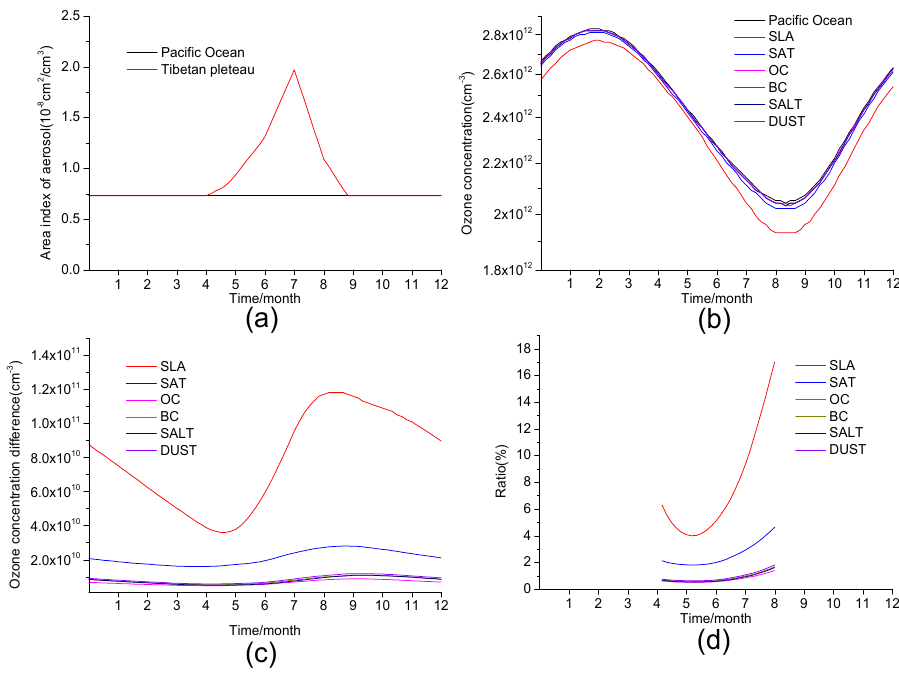
Figure 6. Similar to Figure 5, the modeled ozone response to aerosol changes (SLA is sulfuric acid droplets; SAT is solid sulfate; OC is organic carbon; BC is black carbon; SALT is sea salt; DUST is mineral dust).